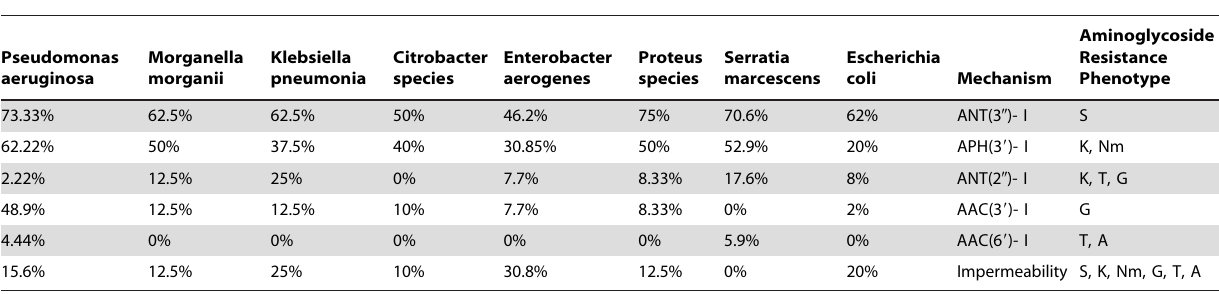
Table 4. Aminoglycoside resistance phenotype and mechanism of Gram-negative bacteria (Interpretative Reading method).